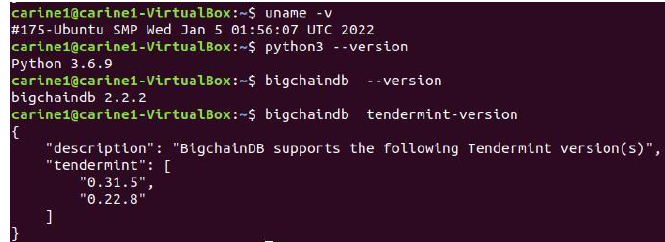
Figure 8. BigchainDB node environment components Versions.